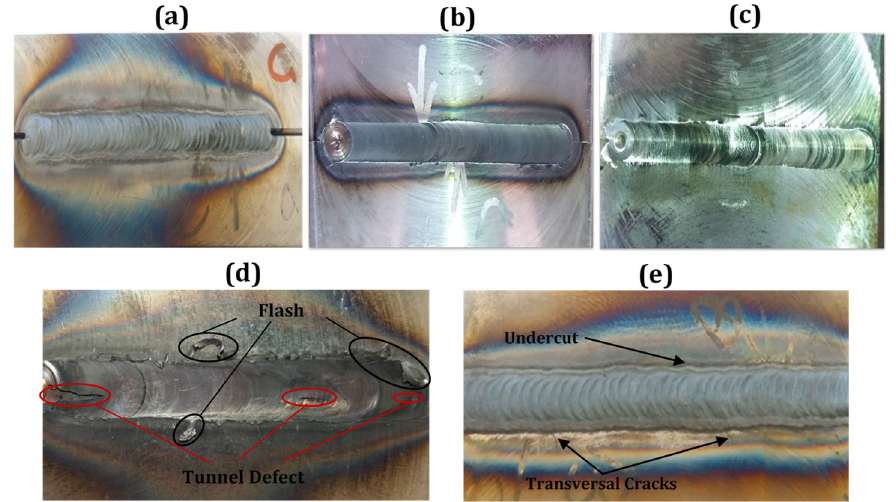
Figure 3. Visual inspection of the surfaces of the welds carried out under various process conditions: ( a ) TIG welded sample with ER70S-6 filler metal, ( b ) friction stir welded (FSWed) sample (950 rpm, 24 mm/min), ( c ) cooling-assisted friction stir welded (CFSW) sample (950 rpm, 24 mm/min), ( d ) FSWed sample (950 rpm, 32 mm/min), ( e ) TIG welded sample (150 A, 1 mm/s).